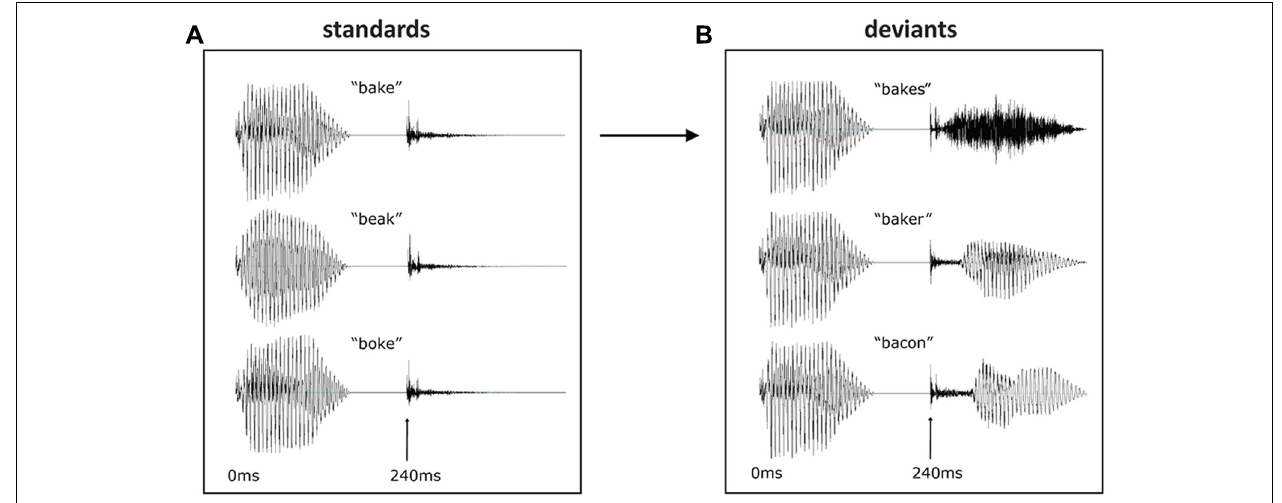
FIGURE 1 |Waveforms of stimuli used as standards (A) and deviants (B). Deviants displayed are for the bake condition, with the three deviant endings following the same stem.The beak and boke conditions were constructed using the same endings. At 240 ms the [k] is released in each condition, marking the deviation point from the